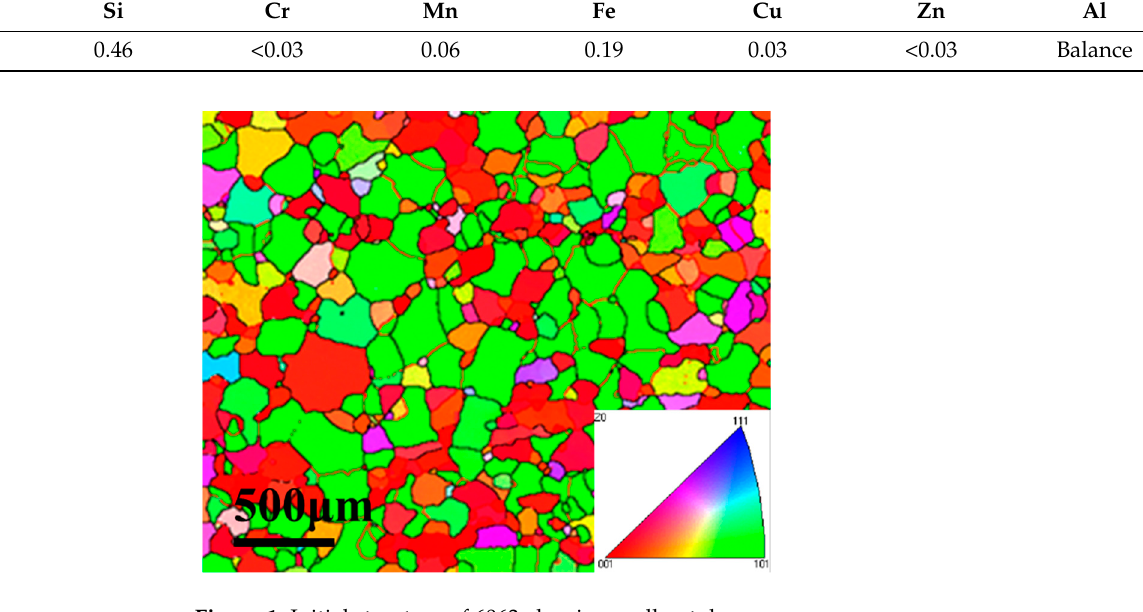
Figure 1. Initial structure of 6063 aluminum alloy tube.